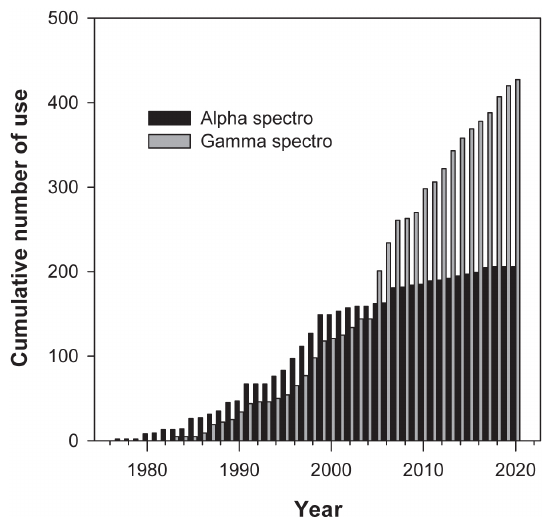
Figure 3. Evolution of the cumulative number of studies using al- pha spectrometry and gamma spectrometry for analyzing 210 Pb xs in sediment sequences between 1977 and 2020.